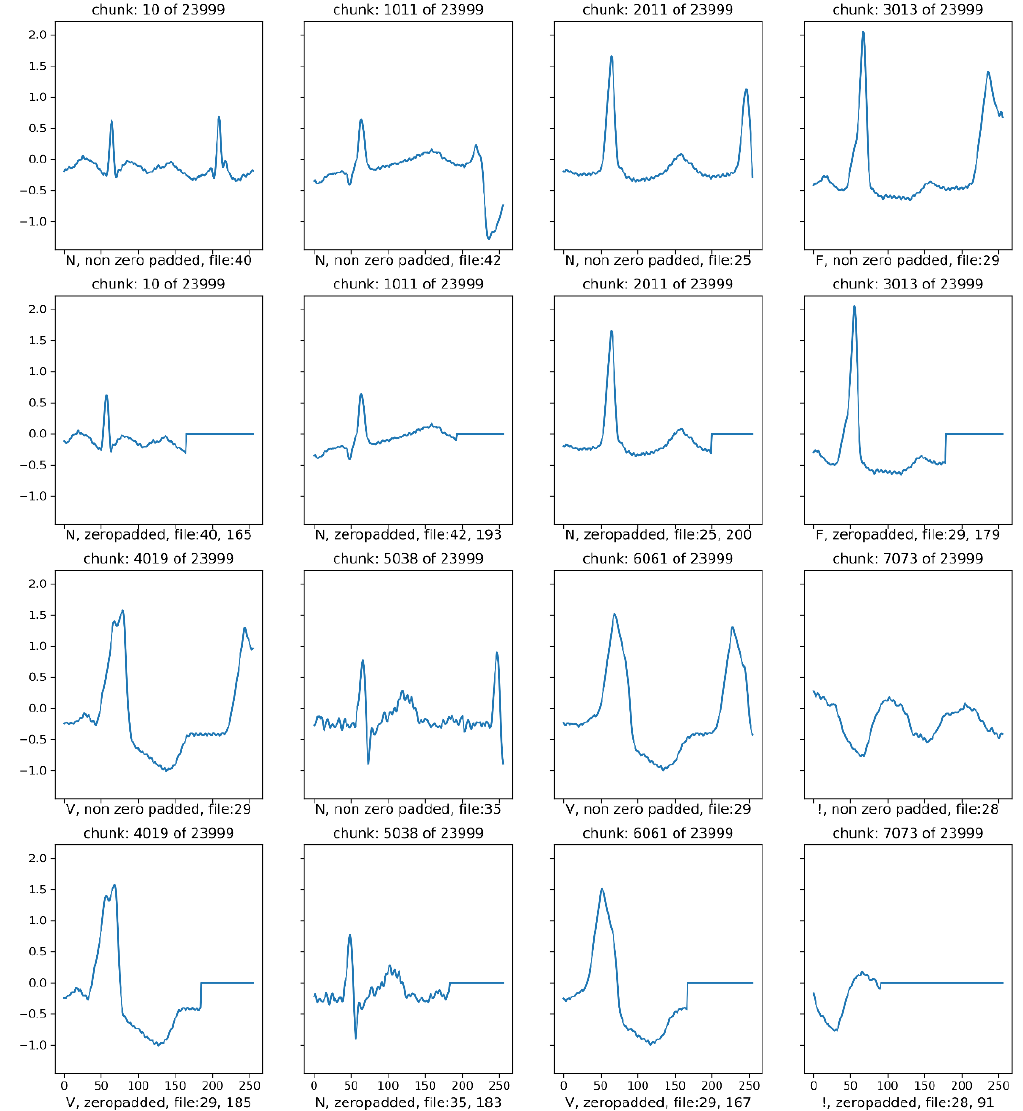
Figure 2. Samples of 16 chunks out of 23,999 beats training data. The 10th chunk, our top left chunk, contains the Normal beat taken from the 40th file. The first and third row were the original signals, while the second and fourth row were the zero-padded signals.